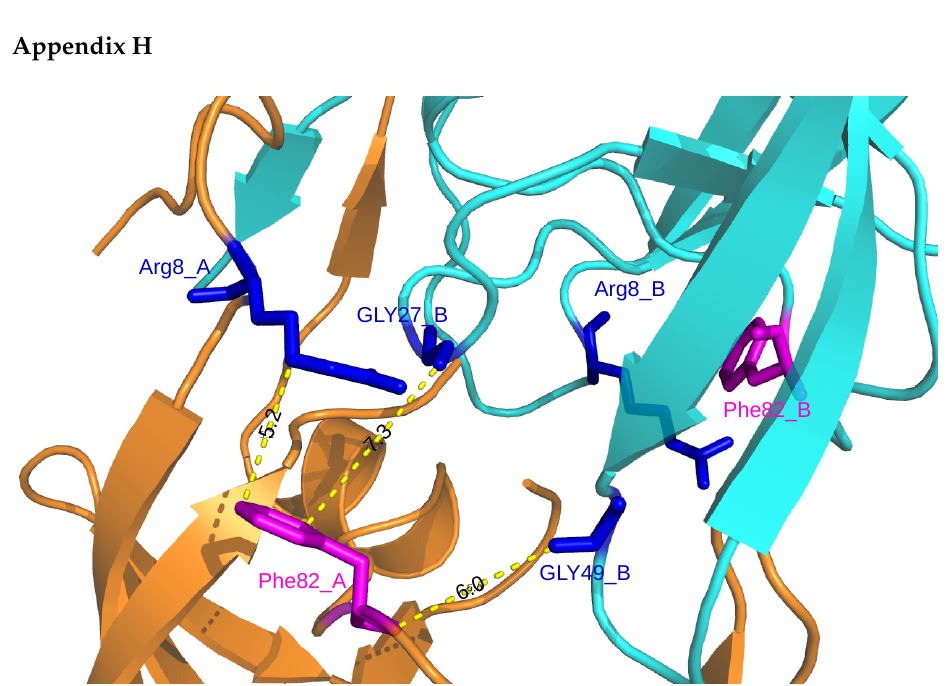
Figure A8. Location of residues exhibiting structural shifts in the I82F mutant. Chains A and B are presented in cartoon mode and colored in orange and blue, respectively. Mutated residues (82) are colored in magenta and presented in stick mode. Residues having shifted atoms are colored in blue and presented in stick